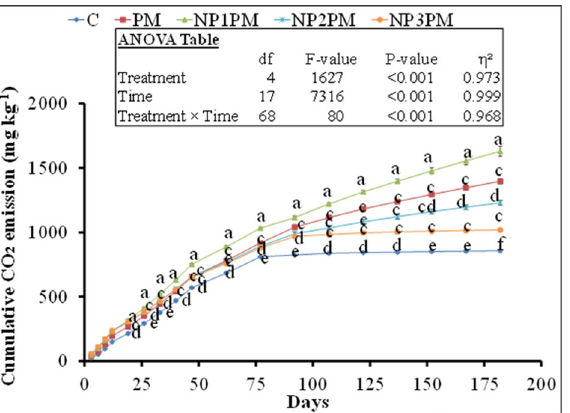
Figure 1. Cumulative CO 2 fluxes from control (C), poultry manure (PM) and NiO nanoparticles (NP) three doses (NP1 = 5, NP2 = 50 and NP3 = 100 mg kg −1 ) mixed with PM amended soil. NiONPs treatments are abbreviated as NP1PM, NP2PM and NP3PM. Error bars showed standard errors (± 1 SE) of the mean (n = 3). Different small letters illustrated significant differences among treatments at a 5% probability level after the Tukey-HSD test. Inset table represented the outcomes of analysis of variance (ANOVA).